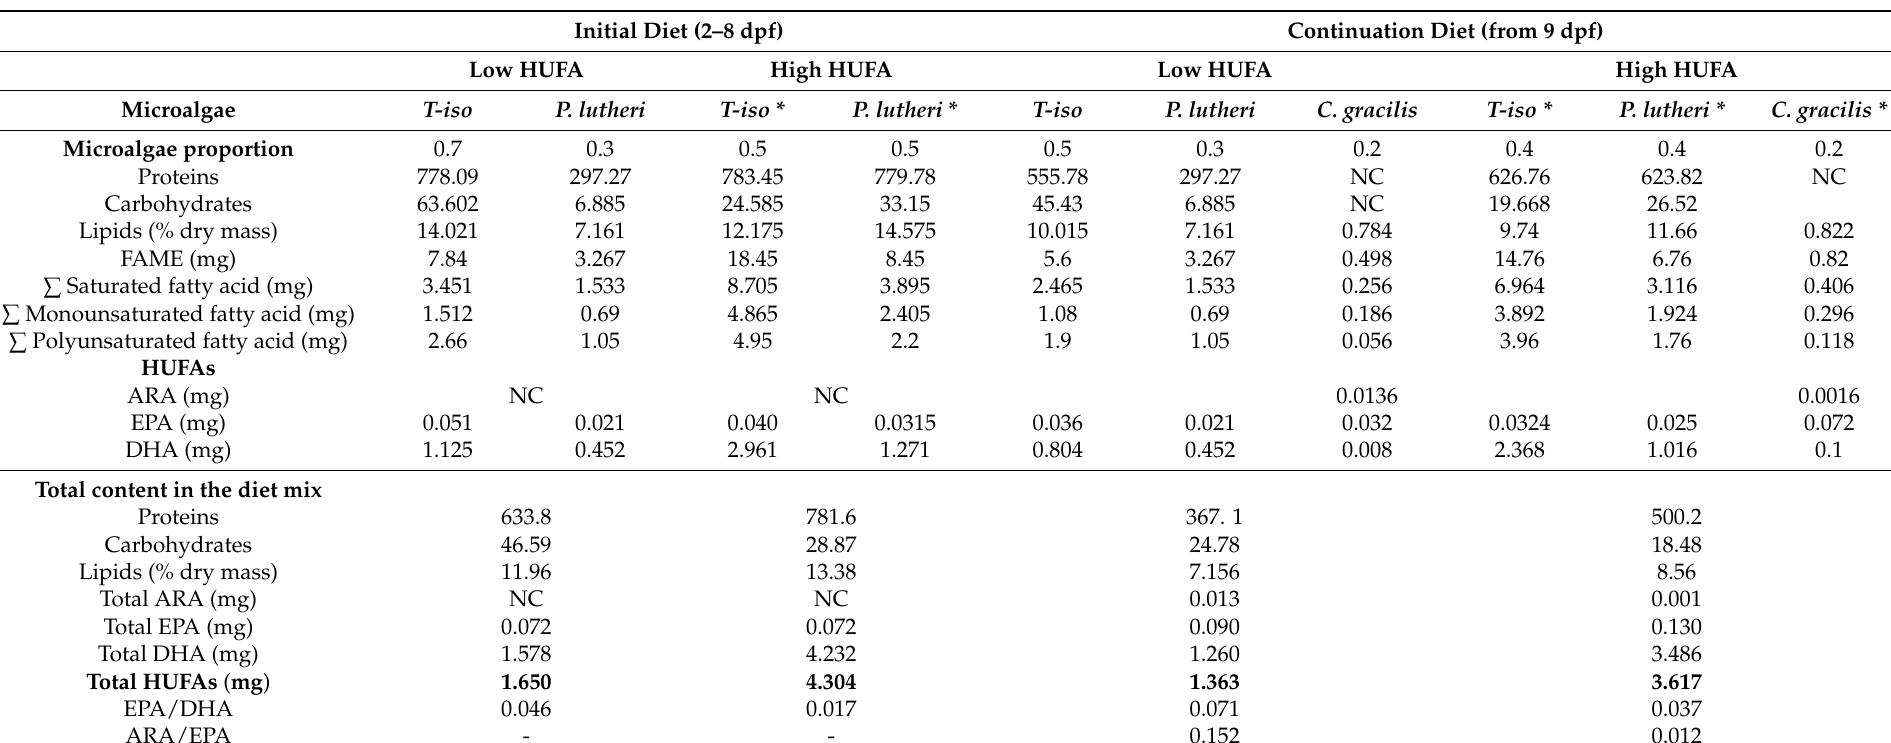
Table 1. Proximate composition and fatty acid content in the microalgae used for each diet (low and high in HUFAs) in the initial and continuation culture periods of Argopecten purpuratus larvae and early juveniles. Fatty acids and HUFAs are expressed in mg · L wet mass − 1